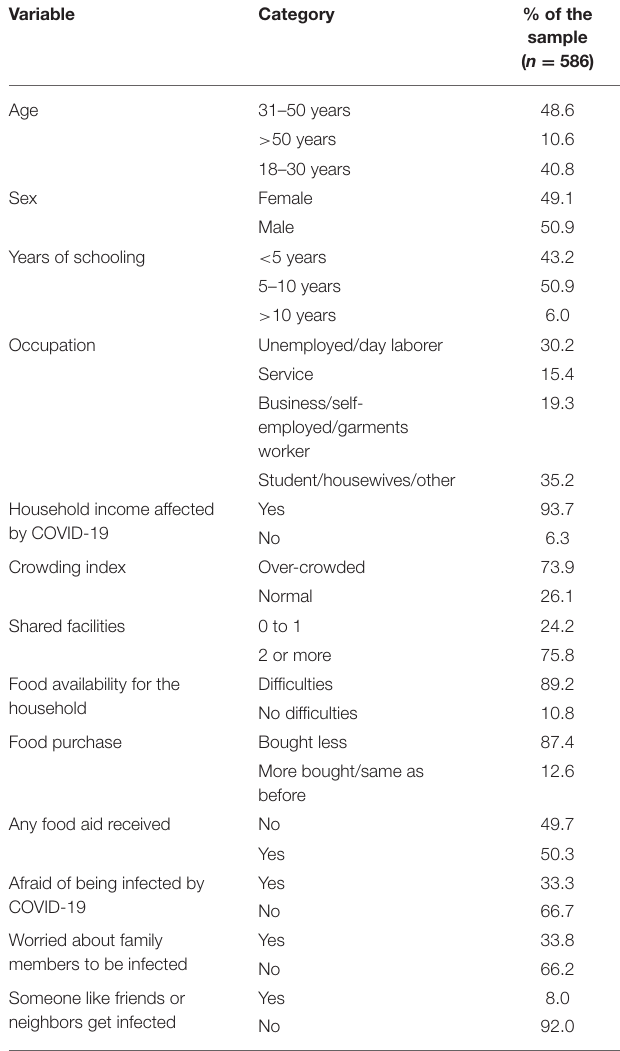
TABLE 1 | Characteristics of the